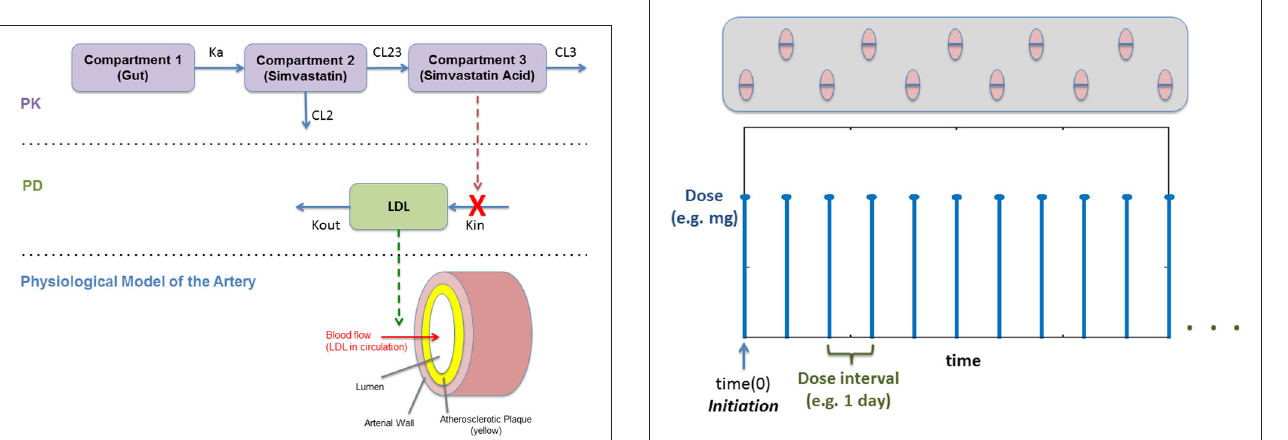
FIGURE 5 | Example time course of how the dose will be administered based on the Discrete Events. Time(0) corresponds to the initiation (Vrijens et al., 2012) (time for the first